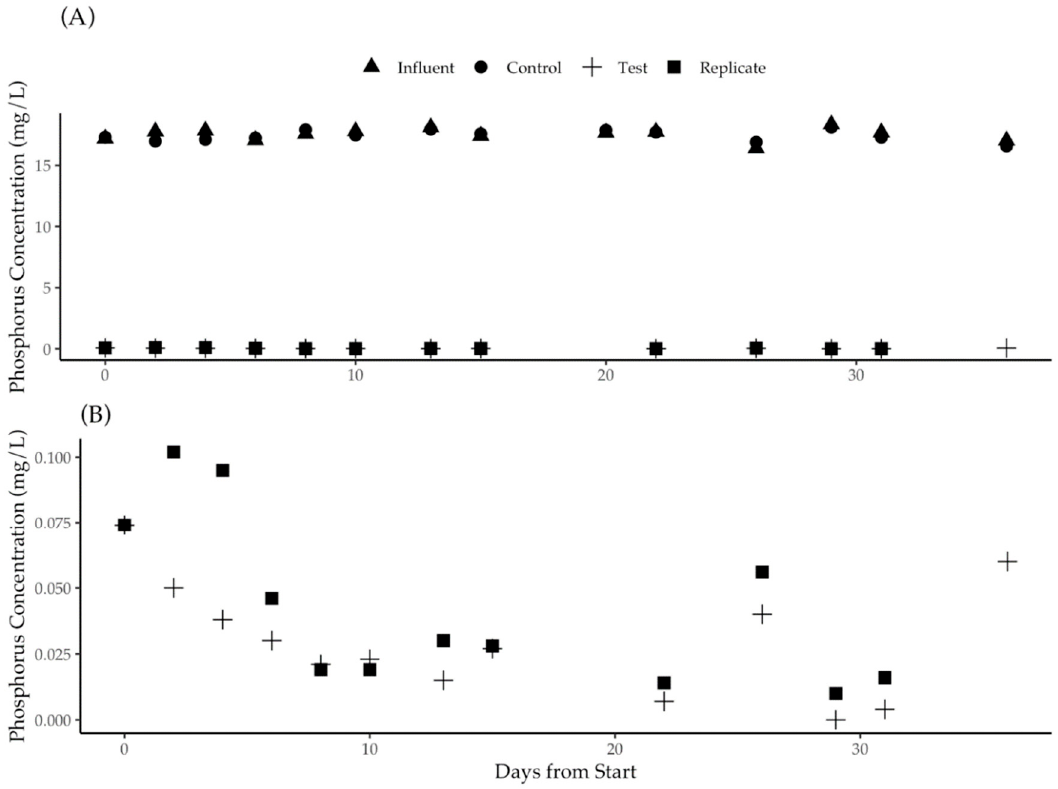
Figure 6. ( A ) Variation of influent and effluent concentrations of phosphorus in the control and treatment systems. ( B ) Rescaled plot ( A ) showing effluent concentrations of phosphorus in the treatment